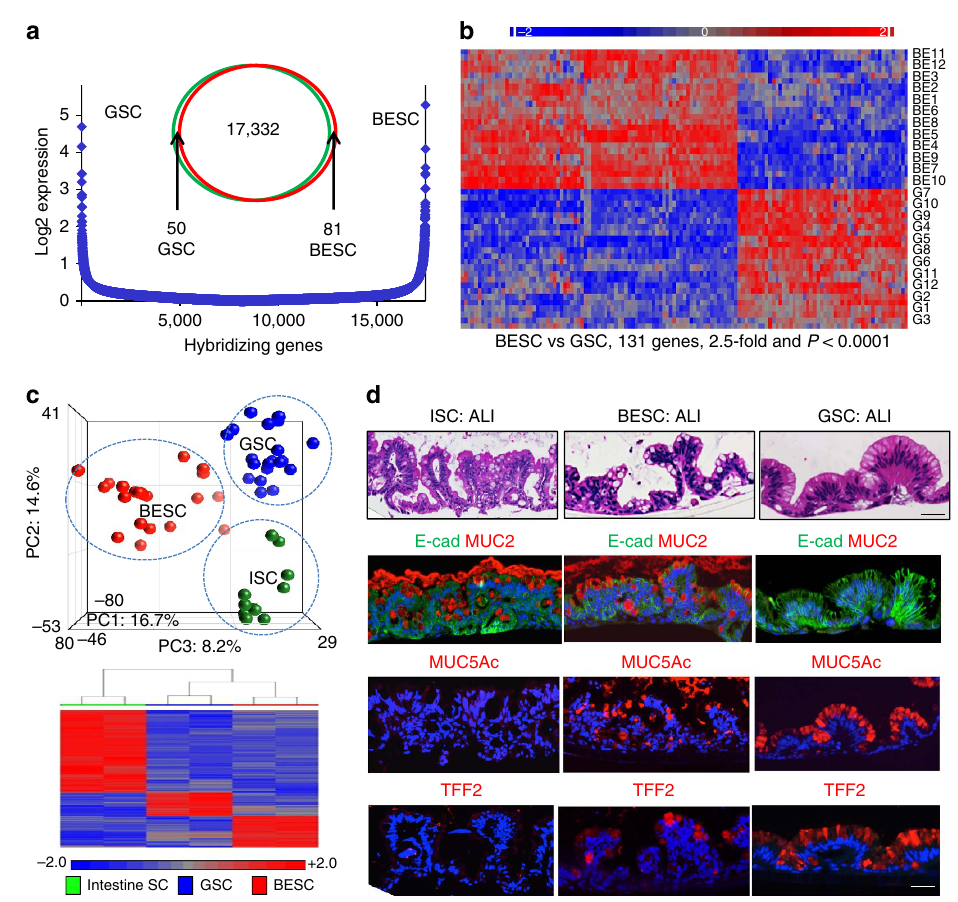
Figure 3 | Stem cells of the gastroesophageal junction. ( a ) Comparison of gene expression microarray data from Barrett’s and gastric stem cells by Log2 expression distribution and Venn diagrams. ( b ) Gene expression heatmap of patient-matched BESC and GSC pedigrees showing relative expression of the 131 most differentially expressed genes between BESC and GSC ( 4 2.5-fold, P o 0.0001). ( c ) Top, PCA of whole-genome expression microarray data of BESC, GSC and stem cells of human fetal intestine (ISC) 16 . Bottom, heatmap of differentially expressed genes between BESC, GSC and ISC. ( d ) Histological sections of ALI-differentiated ISC, BESC and GSC stained with (from top) H&E, E-cadherin (E-cad) and mucin 2 (Muc2) antibodies, mucin 5AC (Muc5AC) antibodies and Trefoil factor 2 (TFF2) antibodies. Scale bar, 50 m m. n ¼ 12 biological